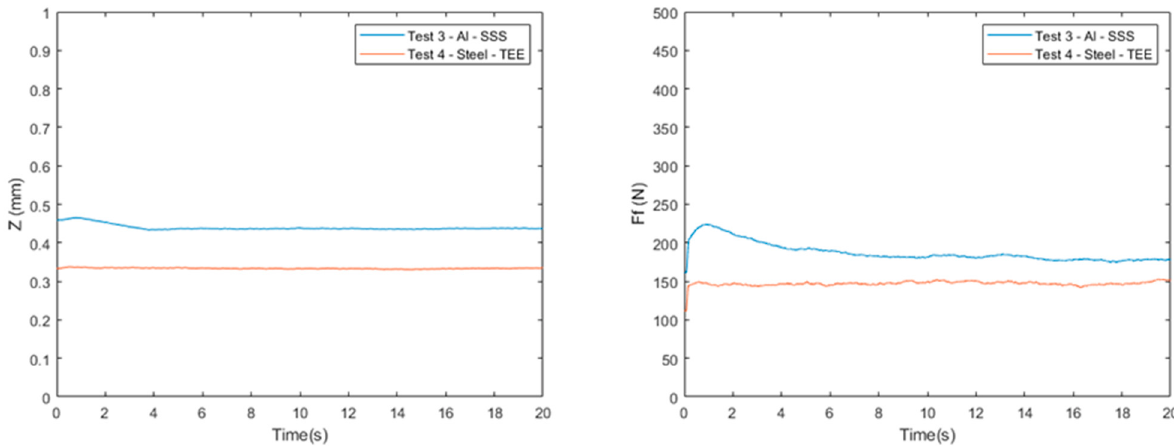
Figure 14. Mechanical data for tool steel indenter on tool steel sheet and tool steel on aluminium sheet under constant load. Depth of cut ( left ) and friction force ( right ).